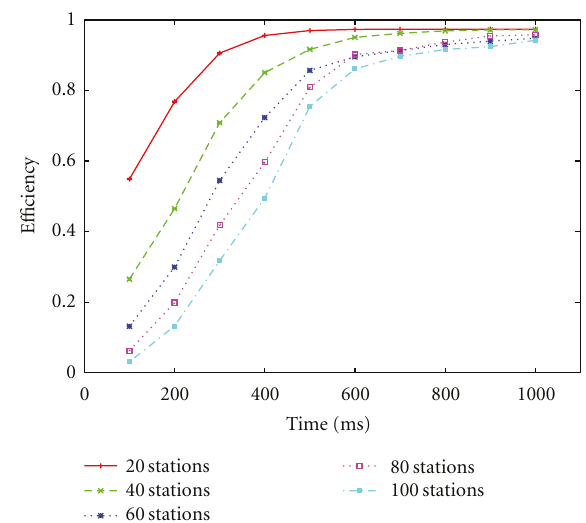
Figure 11: E ffi ciency simulation results when a large number of contenders simultaneously join the